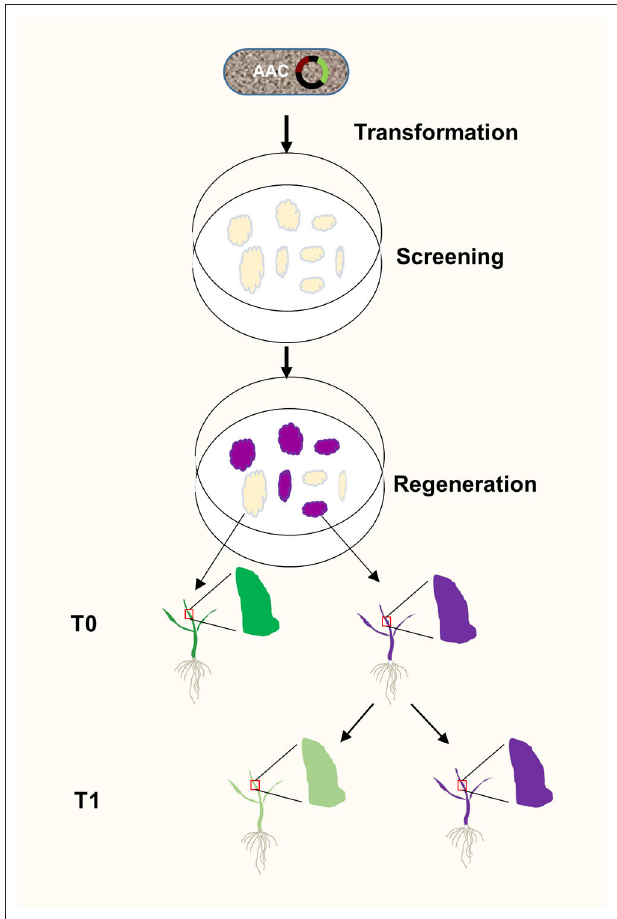
FIGURE 6 | A flow chart of AAC-mediated isolation of transgene-free and target gene-edited rice plants. The AAC plasmid was transformed into rice calli through Agrobacterium -mediated transformation. At the calli stage, the OsC1 gene was expressed to generate purple callus, and the target gene is presumably being edited by Cas9/sgRNA complex. Consequently, at T1 stage, the transgene free plants without purple were selected from the progeny of the purple T0 plants.